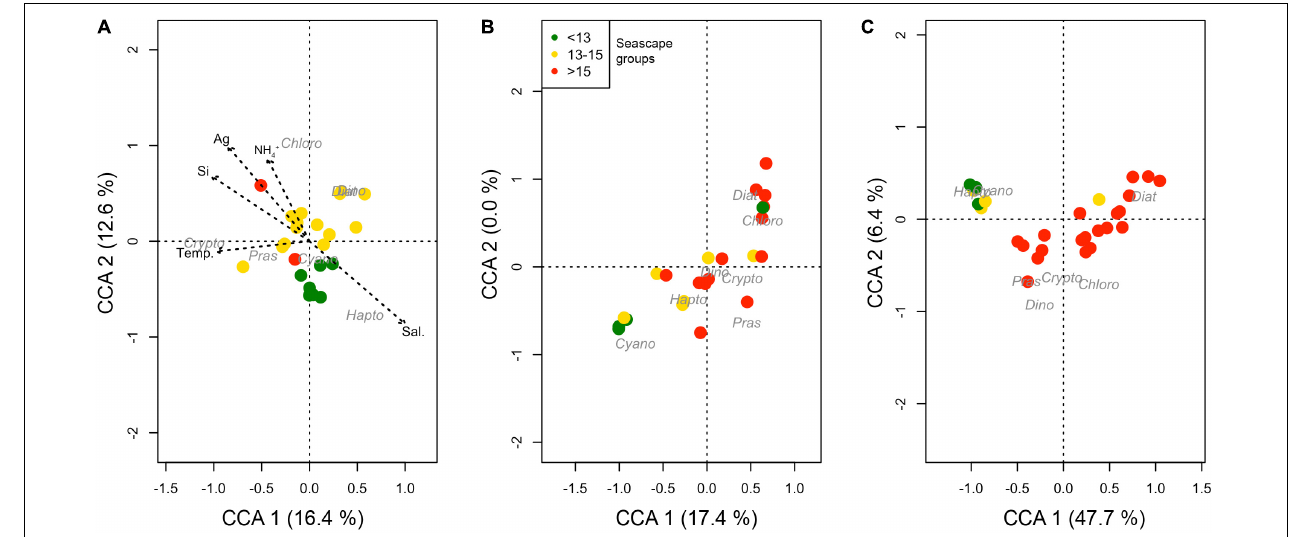
FIGURE 7 | Coordinate correspondence analysis (CCA) of phytoplankton groups based on CHEMTAX outputs and hydrographic variables [temperature, salinity, inorganic nutrients and a g (443) for March, May, and September 2016 (A–C) , respectively]. Dot color represents seascape group (classes < 13 in green, 13–15 in yellow and > 15 in red) identified at the corresponding station for each observation. Arrows are plotted only for March 2016, when a statistically significant ( p -value < 0.05) relationship between environmental variables, phytoplankton groups and seascape class was